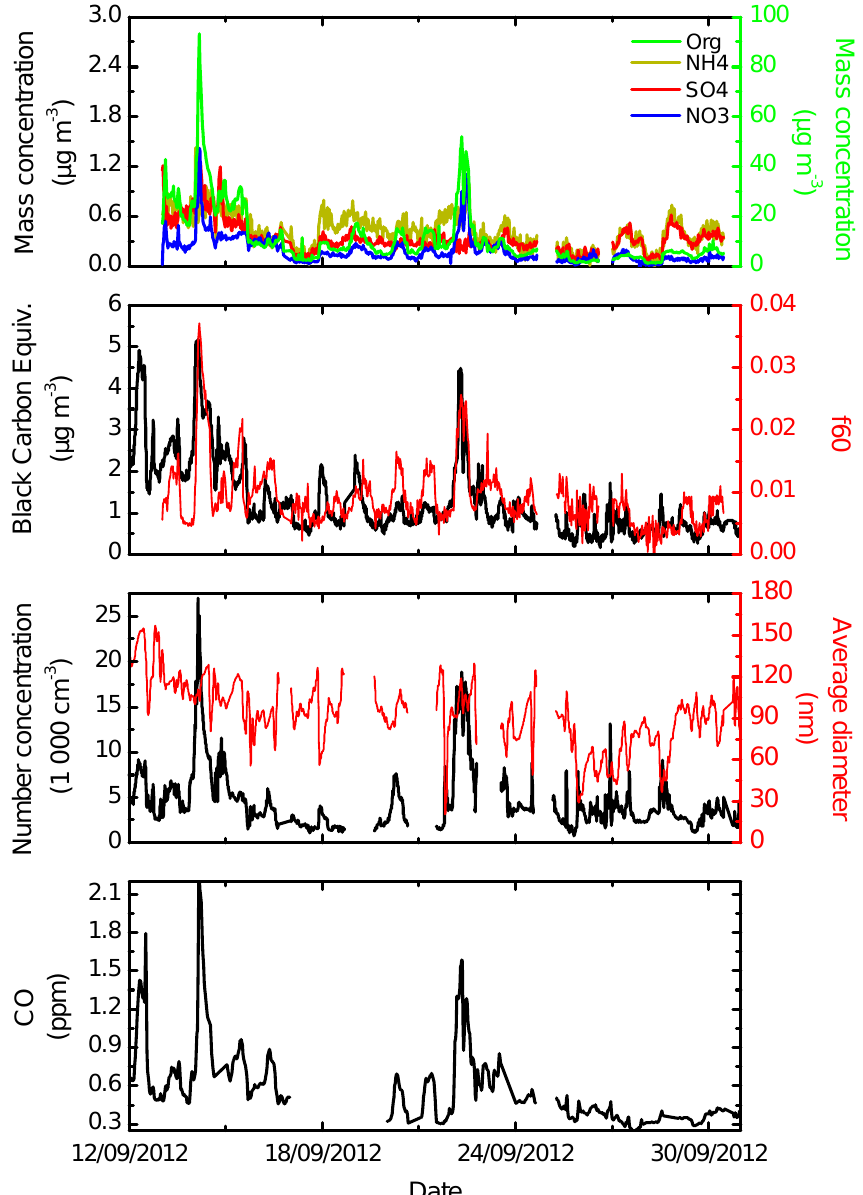
Figure 5. Concentration time series of organics, SO 4 , NO 3 and NH 4 (a) , BC e and f 60 (b) , particle number concentration and number- weighted average diameter (c) , and CO mixing ratio (d)